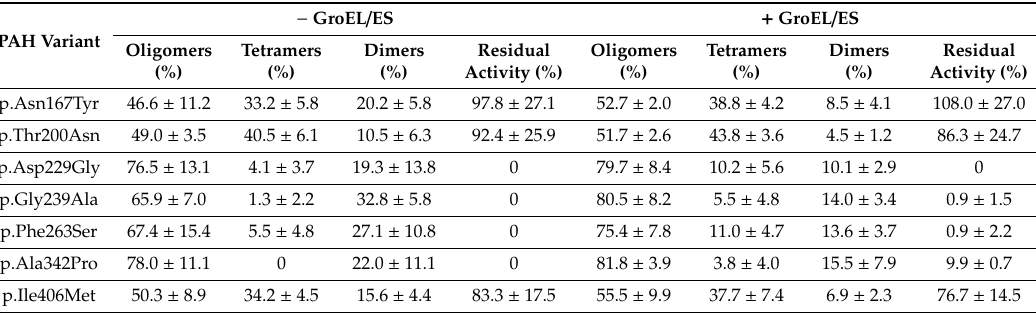
Table 3. The percent representation of individual assemblies of purified (WT) and mutant PAH proteins after their expression in Escherichia coli in the presence and absence of GroEL / ES chaperones determined as a mean of three independent column purifications. The residual activity represents the percentage ± standard deviation (SD) of PAH enzymatic activity compared to WT PAH activity and was calculated as a mean of nine independent functional